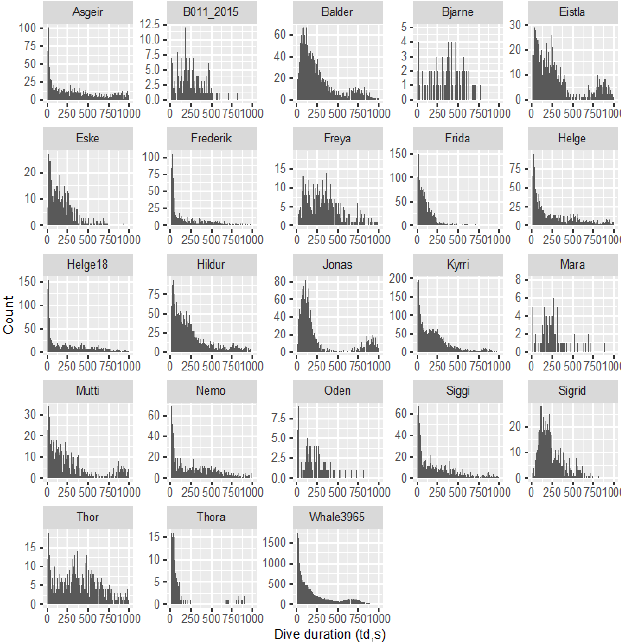
Table 3: Variability in surface time with different depth thresholds for #3965. Only day time periods with measurements within 06:00-18:00 were included. Surface time was calculated with Method 2. Figure 8: Histograms of the distributions of the duration of time spent on